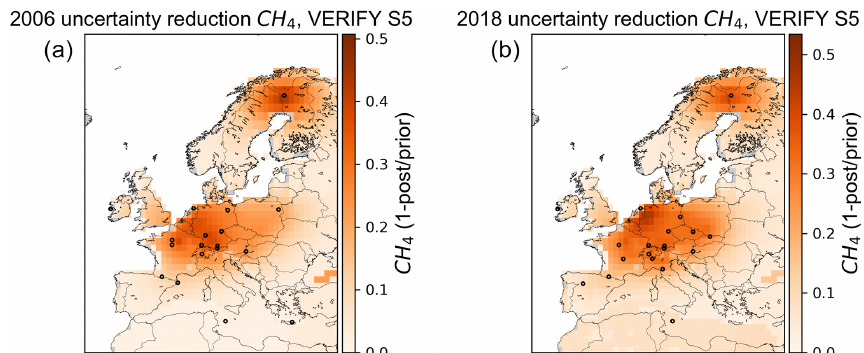
Figure 8. VERIFY_S5 (core) inversion run; uncertainty reduction maps computed as (1 − (cid:49) post /(cid:49) prior) for 2006 (a) and 2018 (b) with different sets of observation stations.